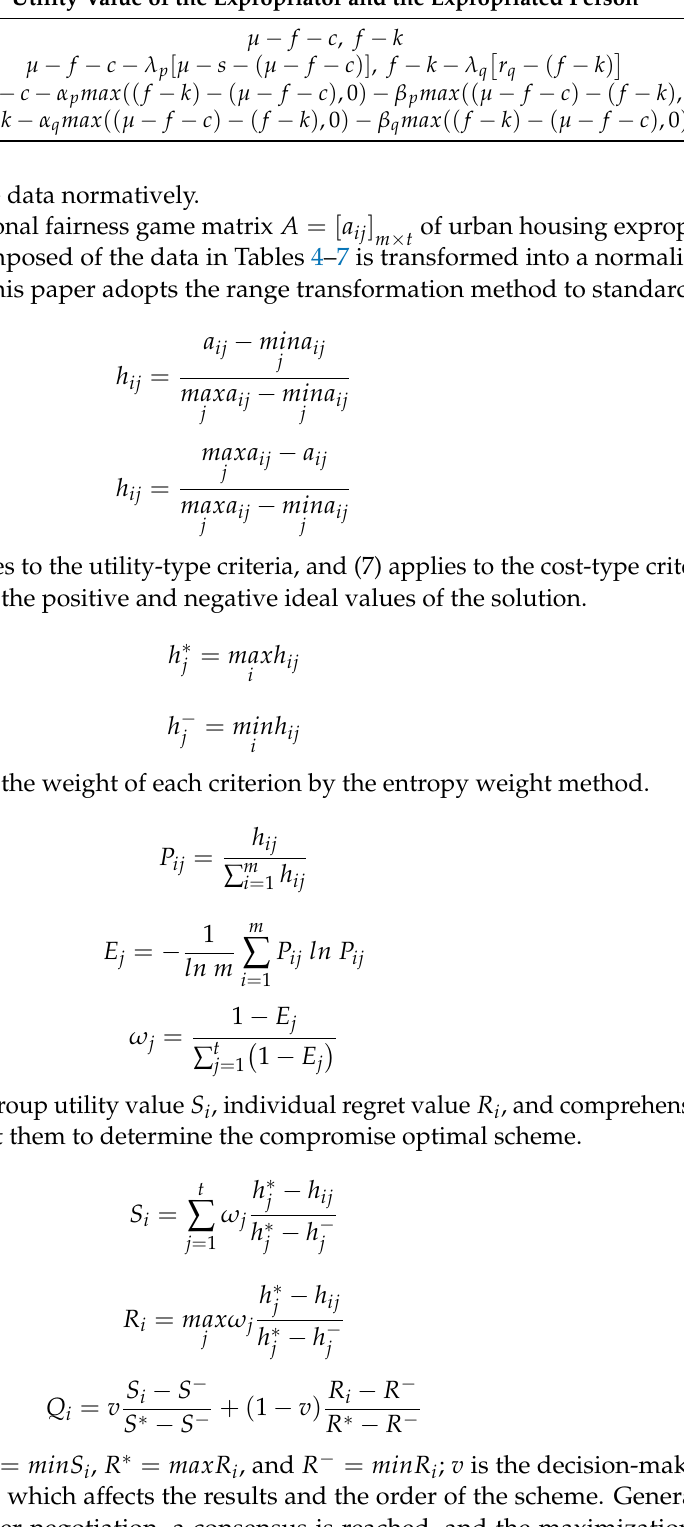
Table 7. Compensation scheme for urban housing expropriation 4 (unfair expropriation, boycott). Utility Value of the Expropriator and the Expropriated